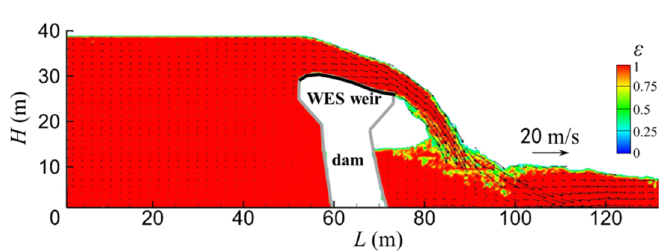
Figure 11. Liquid volume fraction of the vertical section (reservoir water level: 450 m). Table 1. Comparison of the discharge coefficients between the simulated results and the empirical formula results.